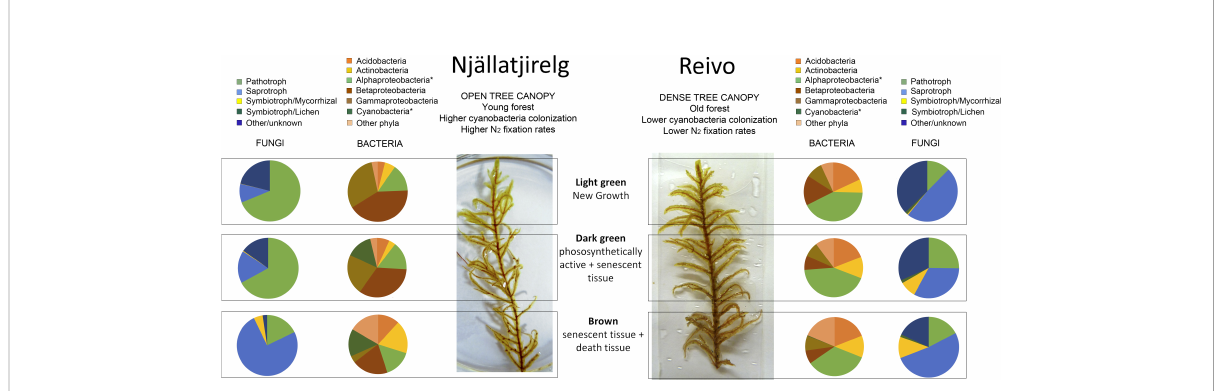
FIGURE 4 Bacterial and fungal community shifts along the Pleurozium schreberi shoot pro fi le revealed by 16S and ITS analysis from two northern Sweden boreal forests. Pie charts represent relative abundance of the major bacterial taxa (brownish pie charts) and fungal trophic mode (blueish pie charts) associated with the light green (new growth tissue), dark green (mature tissue) and brown (senescent tissues) segments of the moss P. schreberi . Samples collected in Njällatjirelg, open canopy forest with high nitrogenase activity, and Reivo, variably dense canopy and moderately nitrogenase activity. Results are based on the number of sequence reads from taxa that could be assigned to genus level or lower (detailed results on Supplementary Table 2 and Supplementary Table 3). Bacterial taxa marked with asterisks were present in the nif H data set (Cyanobacteria 99.90 % and Alphaproteobacteria 0.10 % of the total number of nifH